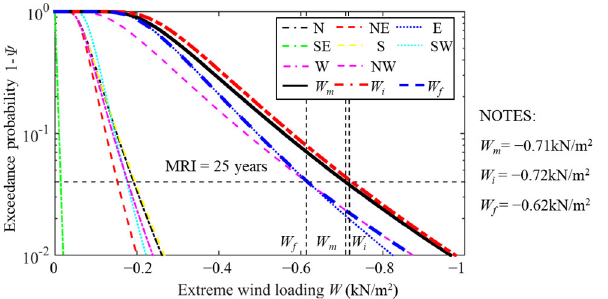
Figure 14. Exceedance probability of extreme wind loading on Module (2–4) with building orientation α = 0° located in Jinan, China.